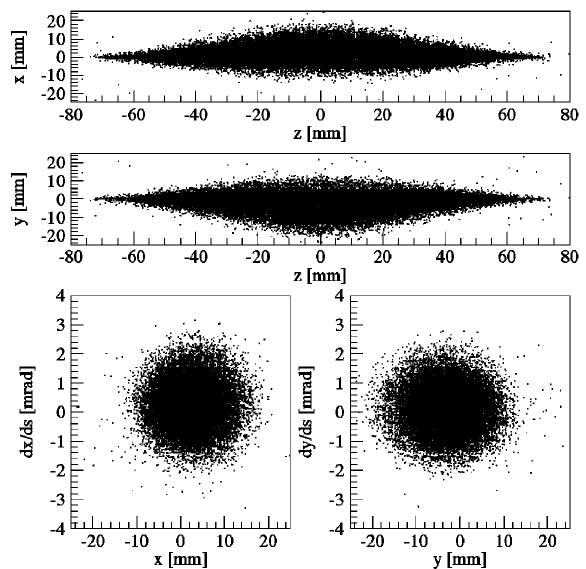
FIG. 2. Charge distribution of the unstable beam snapshot at the EC section at 69 ms.